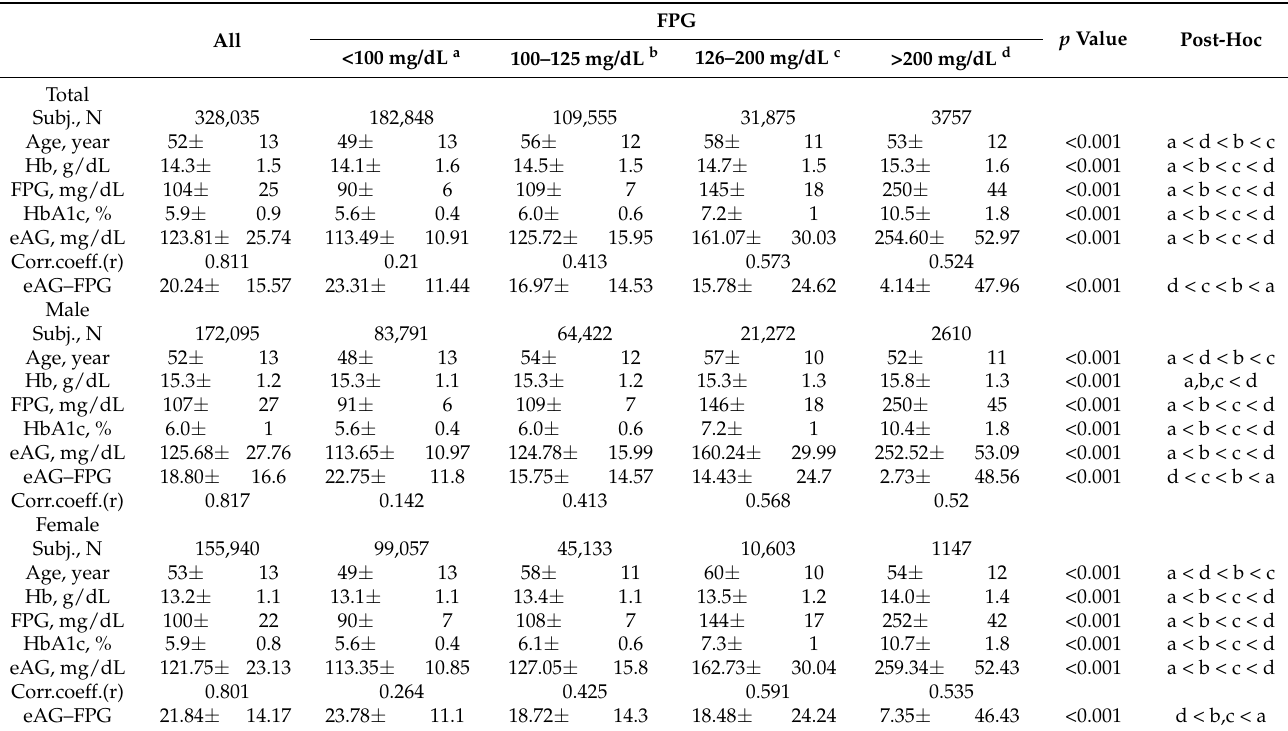
Table 1. Characteristics of study subjects and correlations between fasting plasma glucose (FPG) and estimated average glucose (eAG) according to FPG group.